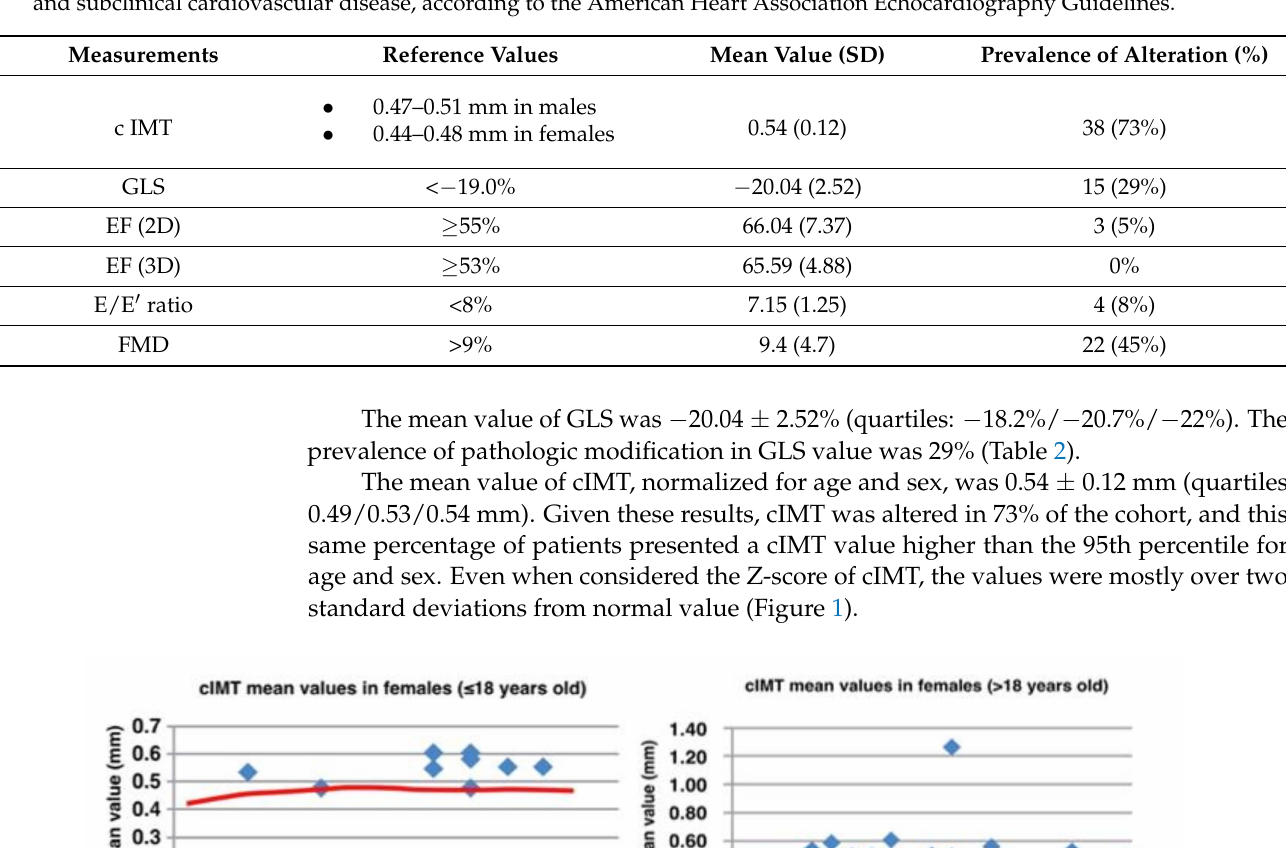
Table 2. Echocardiographic values. Carotid intima media thickness (c IMT), global longitudinal strain (GLS), ejection fraction (EF) measured in 3D and 2D, E/E (cid:48) ratio and flow-mediated dilatation (FMD) were considered markers of clinical and subclinical cardiovascular disease, according to the American Heart Association Echocardiography Guidelines.